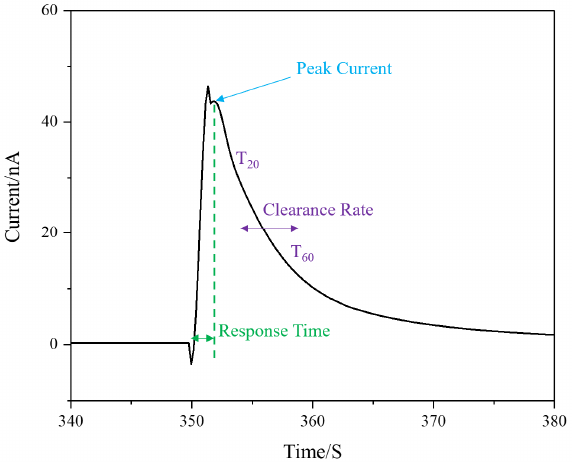
Figure 4. A sample DA signal arising from a single droplet flow across the microelectrode. The method shown was employed for calculating the sensitivity, response time, and clearance rate.